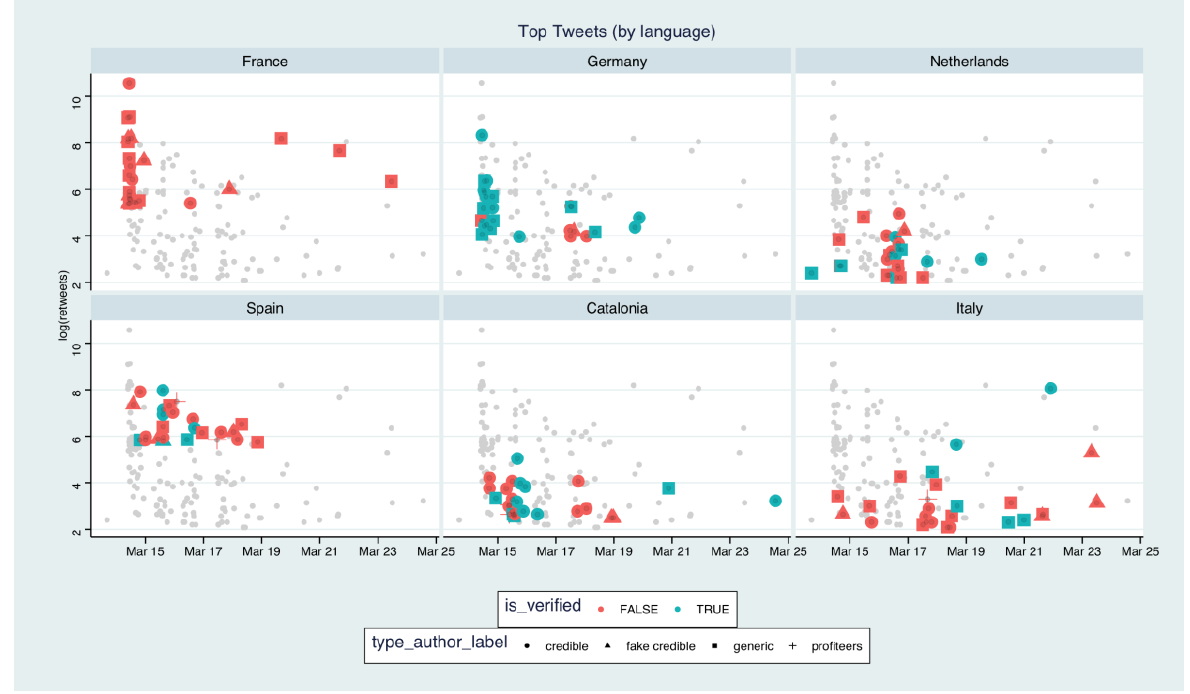
Figure 3. Top tweets by language, truthfulness and author